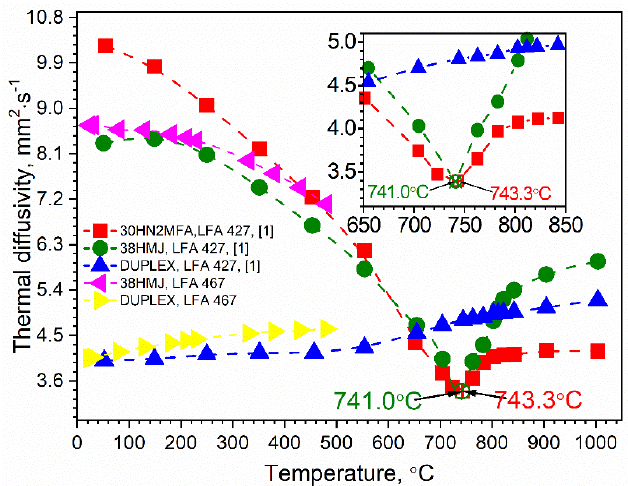
Figure 3. Comparison of thermal diffusivity of barrel steels obtained using LFA 467 and LFA 427 (own measurements vs. literature data).